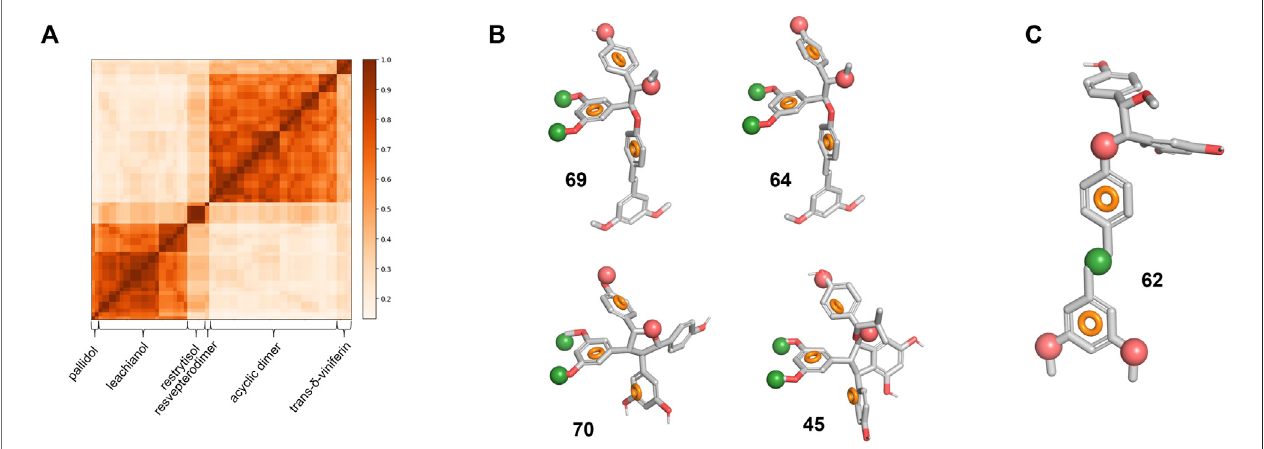
FIGURE 7 | Library chemical similarity and pharmacophore models. (A) Similarity matrix for all six series. A value of 1 corresponds to the identity. (B) Pharmacophoremodelforspeci fi cactivesoverlappedonthefourcompoundswithanSI > 10. (C) Pharmacophoremodelfornon-speci fi cactivesoverlappedon 62 .The red and green spheres represent respectively an H-bond acceptor and a hydrophobic region. The orange circle represents the ideal 3D positioning of aromatic